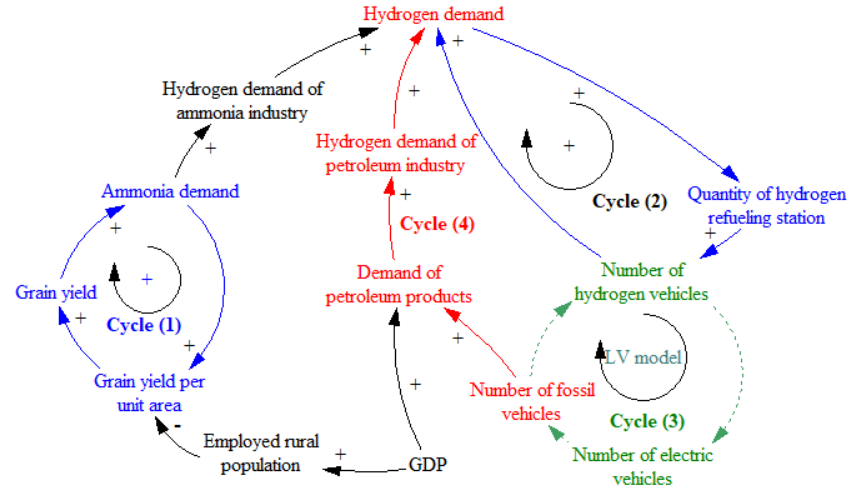
Figure 2. Interaction between macro-economy, industry development, and hydrogen